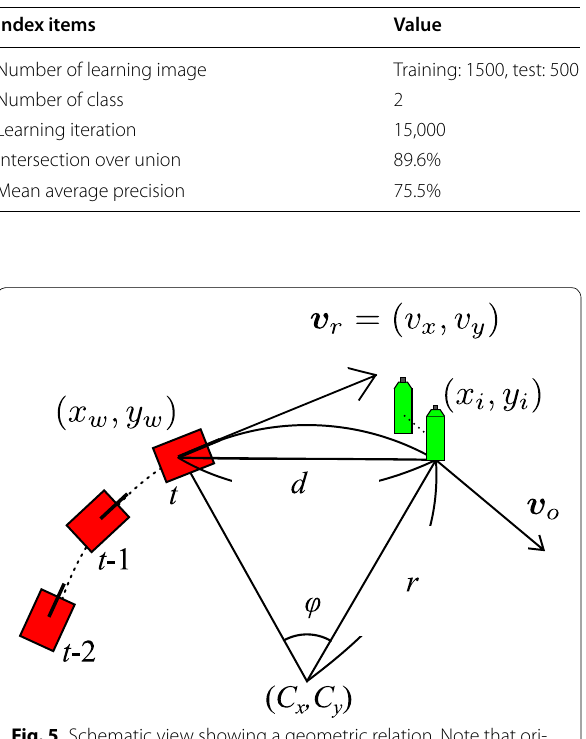
Fig. 5 Schematic view showing a geometric relation. Note that ori‑ gin of positions is defined as position of wide‑view monitoring